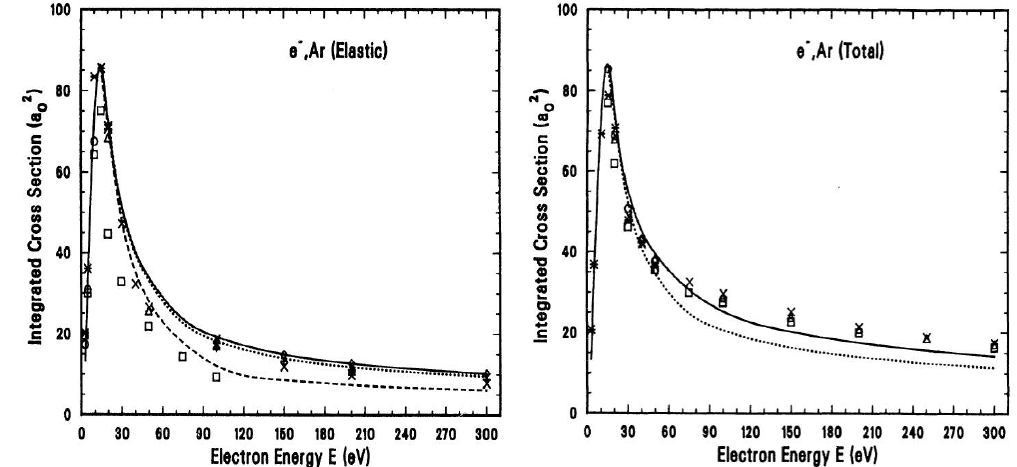
Figure 3. Integrated cross sections for elastic scattering ( left panel) and total scattering ( right panel) of electrons from Ar at various energies. A rising broad peak in cross section in the low energy below 30 eV is visible [9]. Comparison show good agreement as explained in the